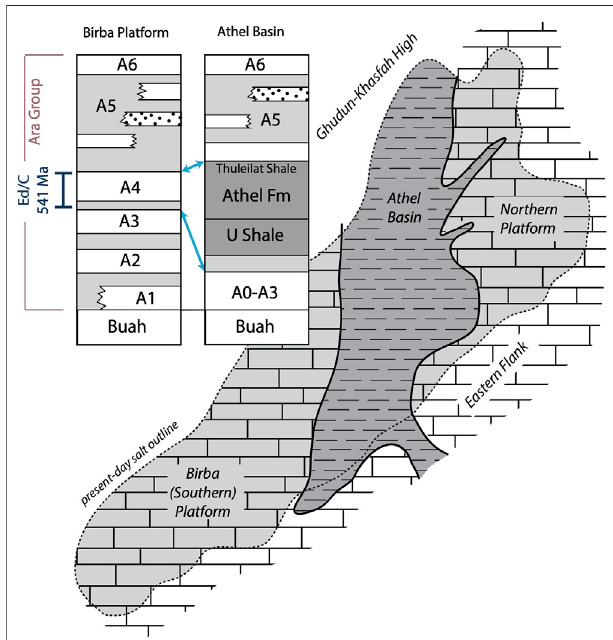
FIGURE 1 | Outline and stratigraphy of platform and basin in the South Oman Salt Basin. Deposits of the deep-water Athel subbasin are time equivalent to the A4 carbonate-evaporite couplet on the adjacent shallow platform. After Schröder et al. (2005).